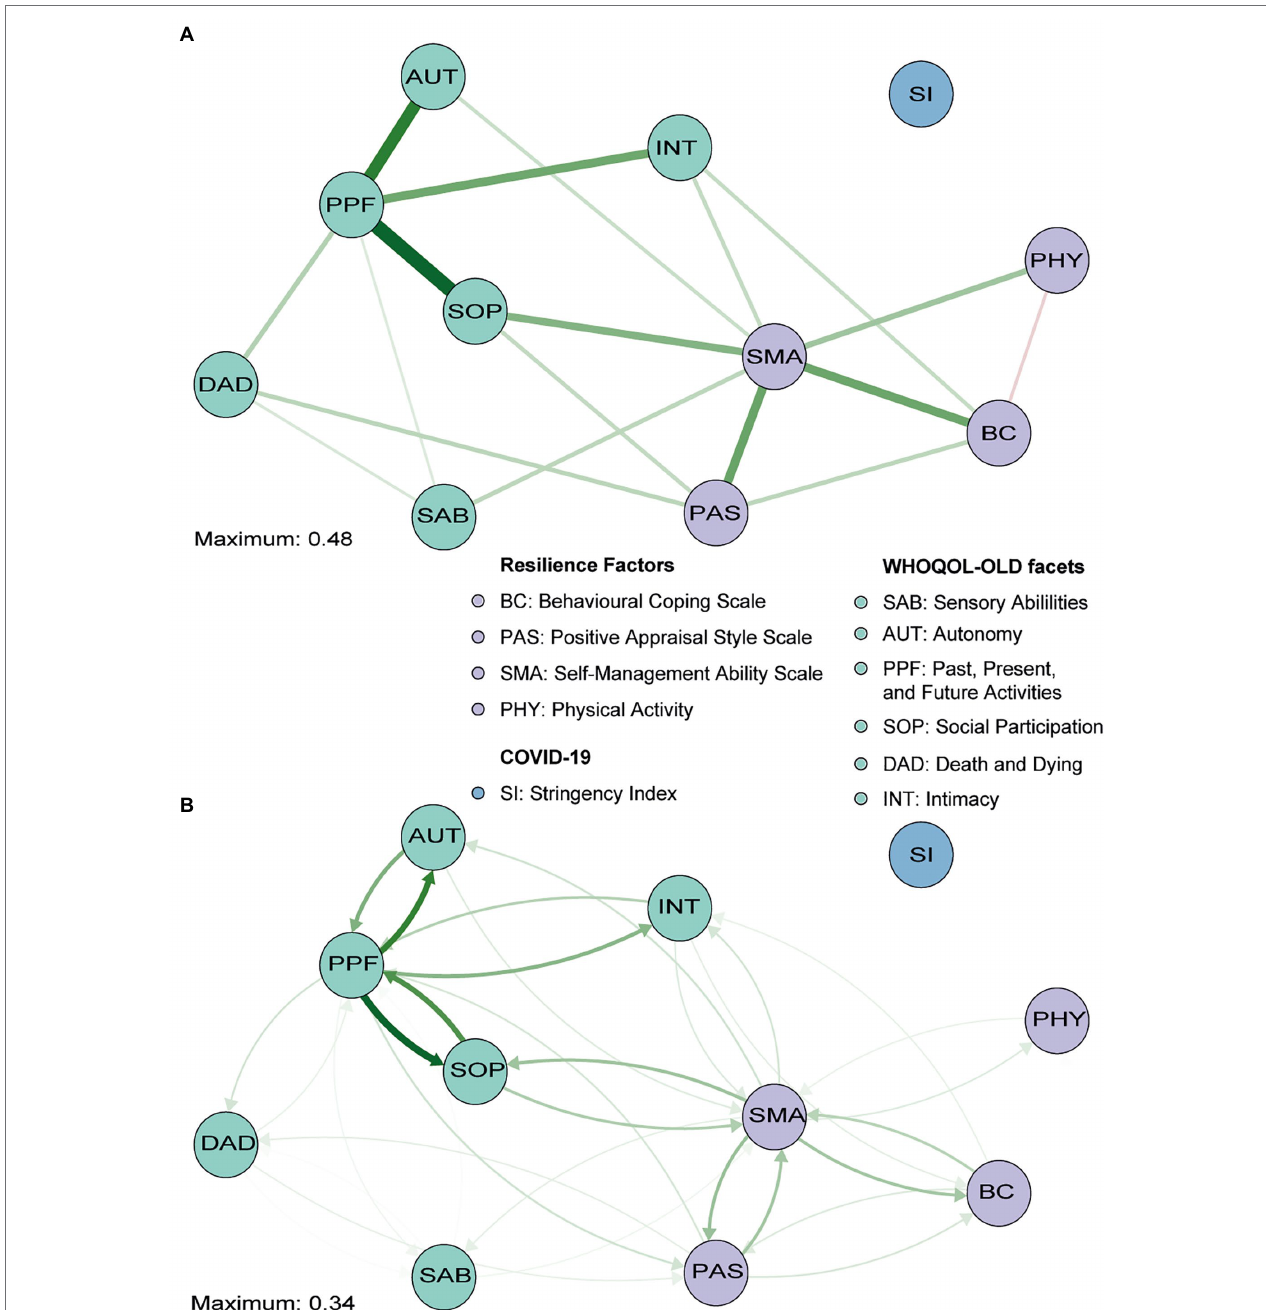
FIGURE 3 | Gaussian graphical model (GGM; A ) and directed relative importance network (B) of individual facets of QoL (green), the resilience factors (purple), and the stringency index (blue). The maximum value represents the highest edge weights included in the network. Note that the direct relationship from positive appraisal (PAS) to past, present and future activities (PPF) is covered by the social participation (SOP) node and that PAS is thus not directly related to SOP (only indirectly via